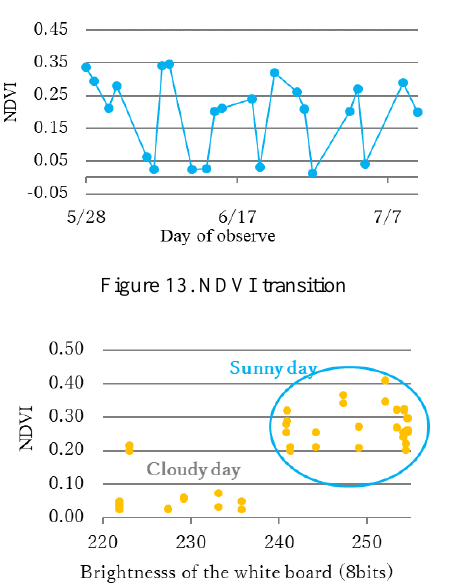
Figure 17. Conifer's photo at Aug. 23 and Sep. 4